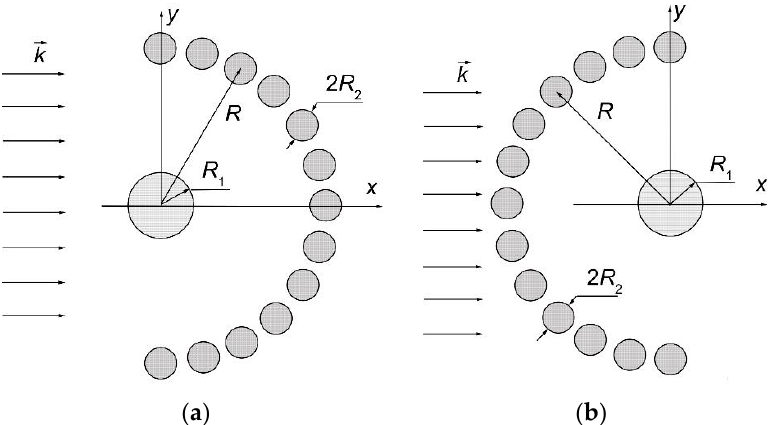
Figure 1. Lossy metamaterial-semiconductor array structures when: ( a ) Thirteen semiconductor cylinders are placed on the right side of the central metamaterial cylinder; ( b ) the cylinders are placed on the left side of the central metamaterial cylinder.